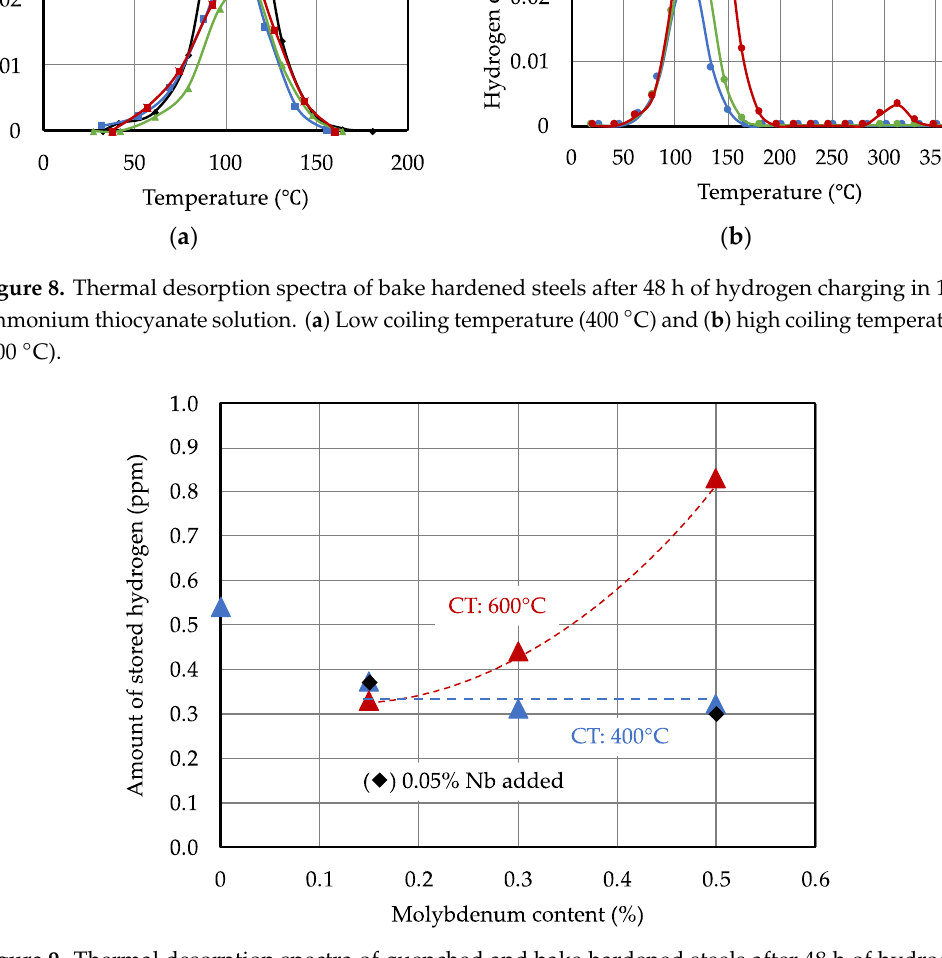
Figure 9. Thermal desorption spectra of quenched and bake hardened steels after 48 h of hydrogen charging in 10% ammonium thiocyanate solution.